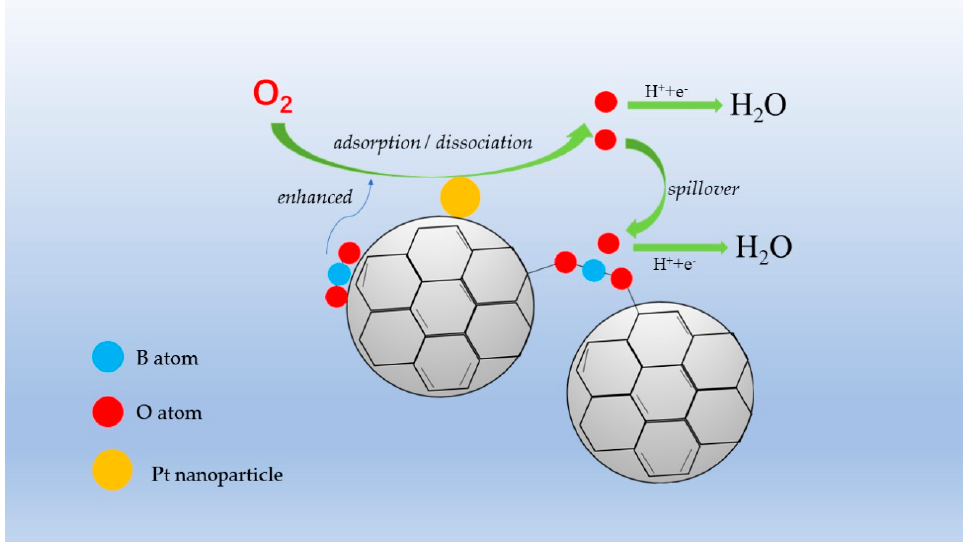
Table 1. The electrochemically-active surface area (ECSA), mass activity (MA), and area specific activity (SA) of Pt/ECP600 and